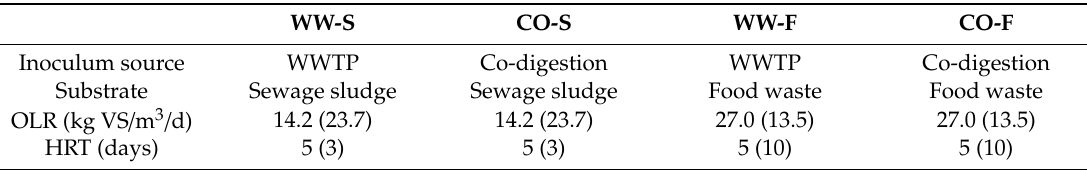
Table 1. Origin of inoculum, substrate, organic loading rate (OLR), and hydraulic retention time (HRT) for the di ff erent reactors (week averages). Values in brackets refer to after day 20 for reactors CO-F and WW-F, and after day 50 for reactors CO-S and